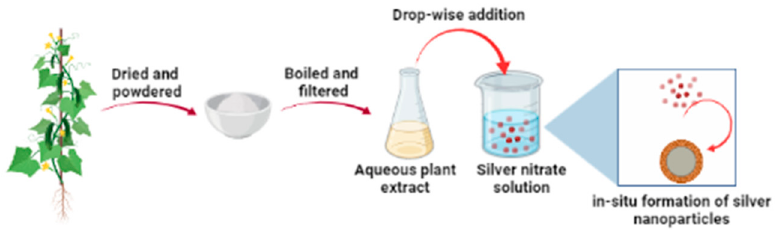
Figure 3. Illustration of the process of in situ synthesis and stabilization of silver nanoparticles.